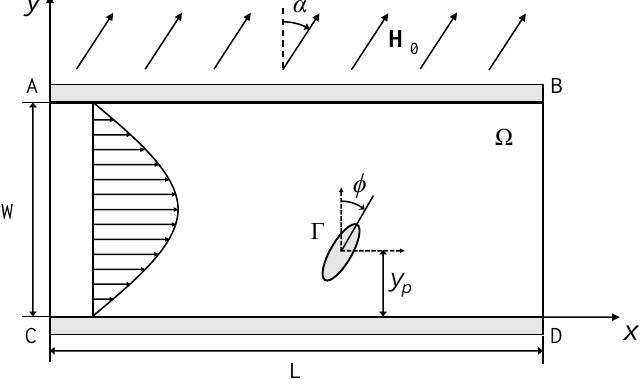
Figure 1. Schematic view of the numerical model of an elliptical particle suspended in a plane Poiseuille flow under the influence of a uniform magnetic field H 0 . The fluid and particle domains are Ω and Γ , respectively. The orientation angle of the particle is denoted by φ . The particle–wall separation distance is denoted by y p